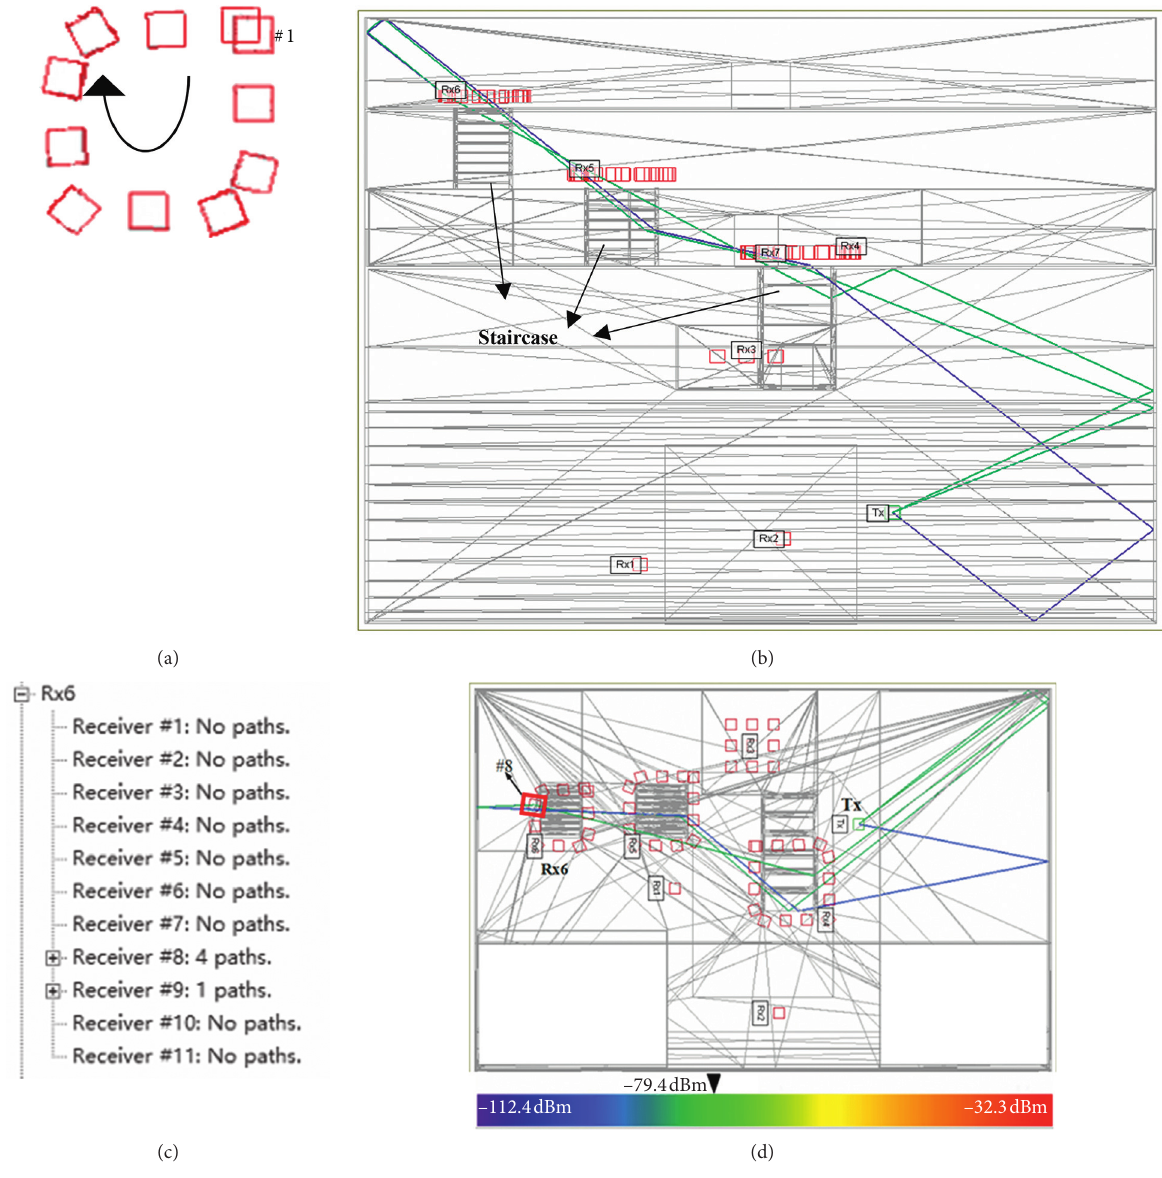
Figure 8: Simulated results of the Rx6 receiver. (a) Node deployment of Rx6. (b) The effective reception path situation of Rx6. (c) The side view of transmission paths of the #8 node Rx6. (d) The vertical view transmission paths of the #8 node